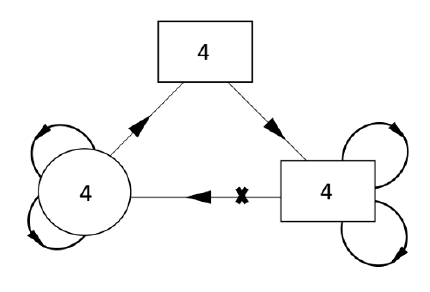
Figure 4. The 4 d theory one gets after giving a vev to the baryon associated with the bottom right SU(4) (cid:2) SU(4) bifundamental. This is just a Spin(6) gauge theory with two chiral (cid:12)elds in the vector representation, 4 in the spinor and another 4 in the conjugate spinor. Additionally there are various chiral (cid:12)elds (cid:13)ipping the gauge invariant operators: SSV; S (cid:22) S; S 4 . There is also a decoupled (cid:12)eld coming from one of the previous